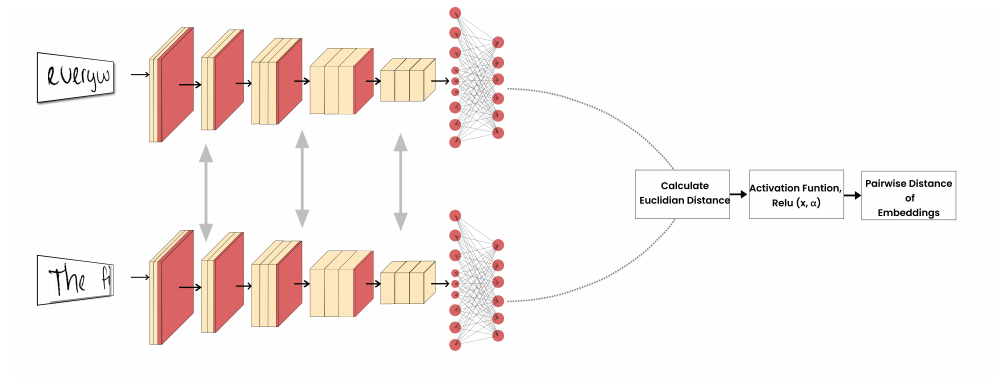
Figure 4. The training architecture of AutoEmbedder using a Siamese neural network (SNN). The subnetwork of SNN is weight-sharable, and the activation function is Relu, which is described in Equation (4). The architecture calculates pairwise distance output based on the generated embed- dings